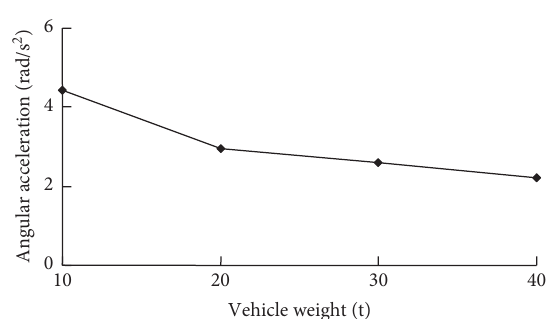
Figure 28: The variation curve of weighted vibration acceleration RMS value of the vehicle